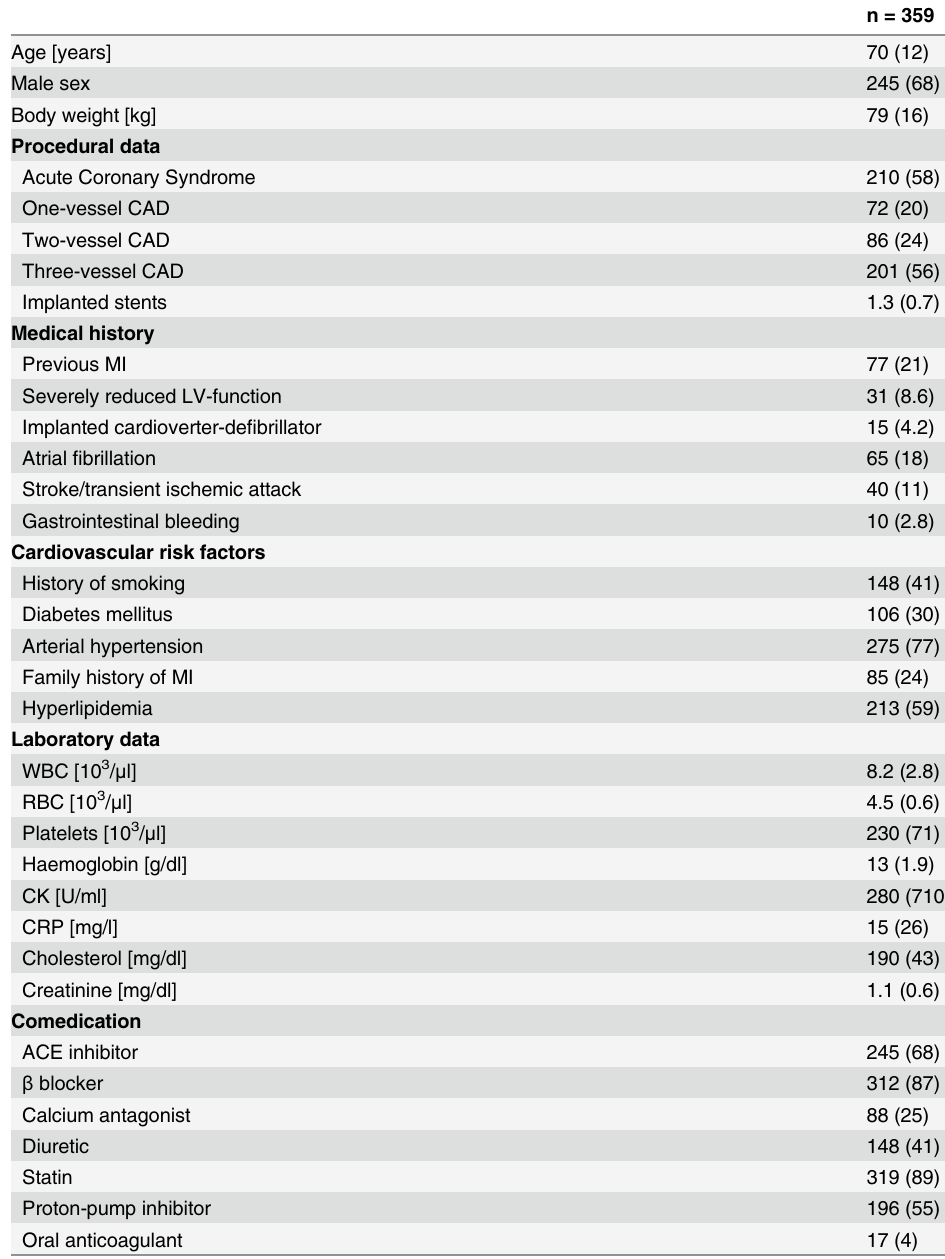
Table 1. Clinical baseline